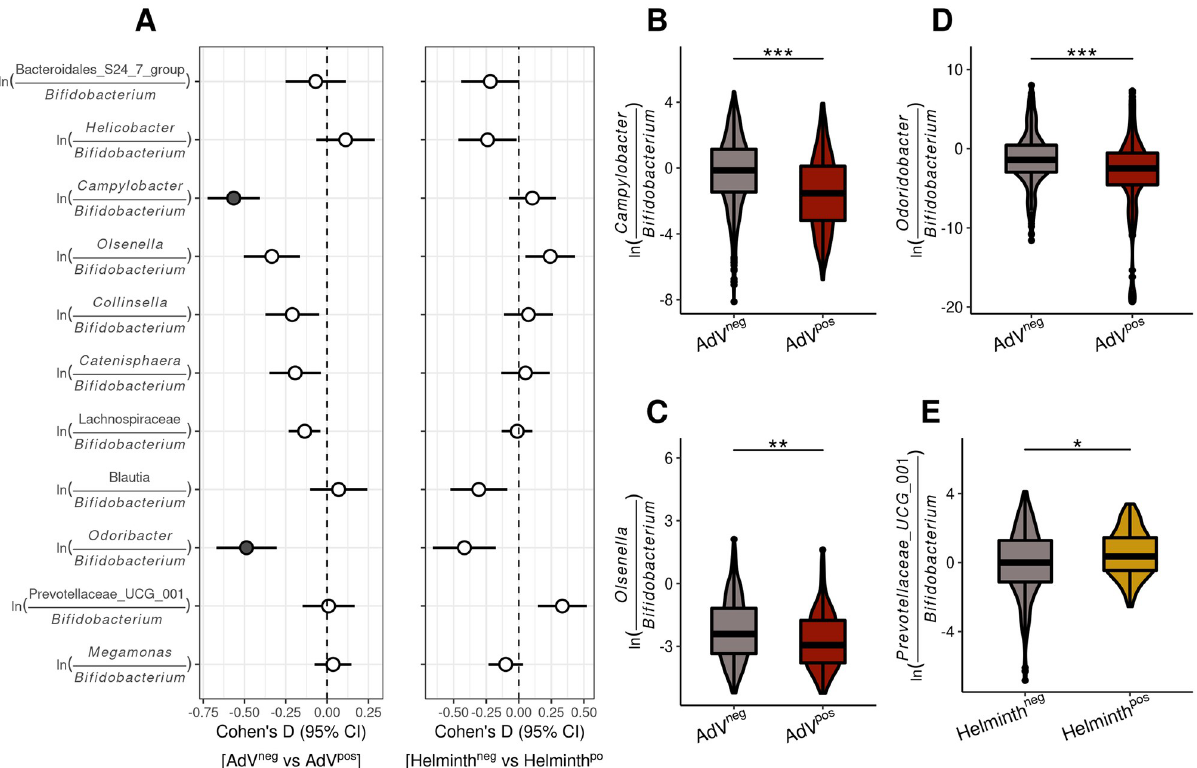
Fig 4. Bacterial taxa associated with MHC motifs and functional diversity are significantly associated with AdV and helminth infection status. (A) Effect size (Cohen’s D and CI) forest plots of the log-ratios of taxa associated to MHC motifs and to MHC functional diversity with respect AdV and helminth infection. Filled symbols represent log- ratios with medium to large effect sizes (Cohen’s D | > 0.50|). ASVs of the genus Bifidobacterium were used as a reference frame to calculate the log-ratios. (B-E) Violin box-plots illustrating the significant log-ratio across AdV (n = 143) and helminth (n = 85) infection status. � P < 0.05; �� P < 0.005; ��� P < 0.0005.